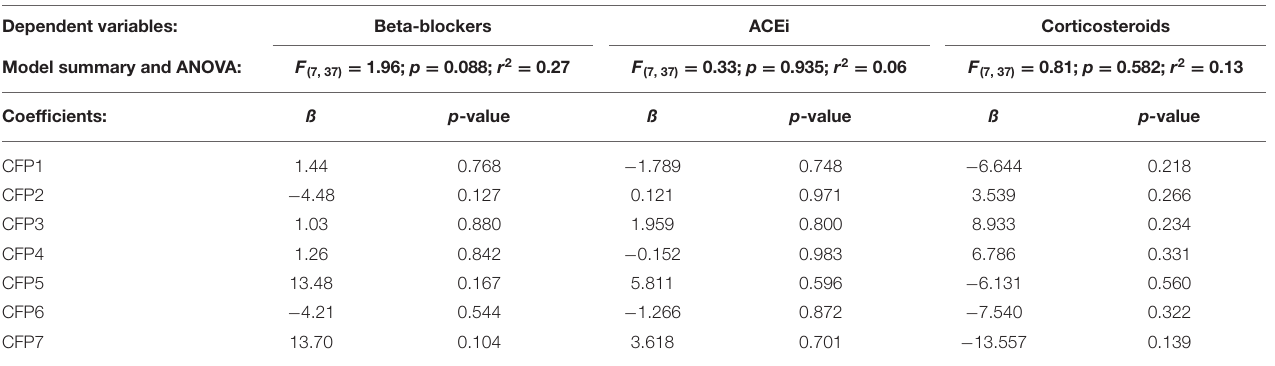
TABLE 6 | The table illustrates the regression models and three dependent